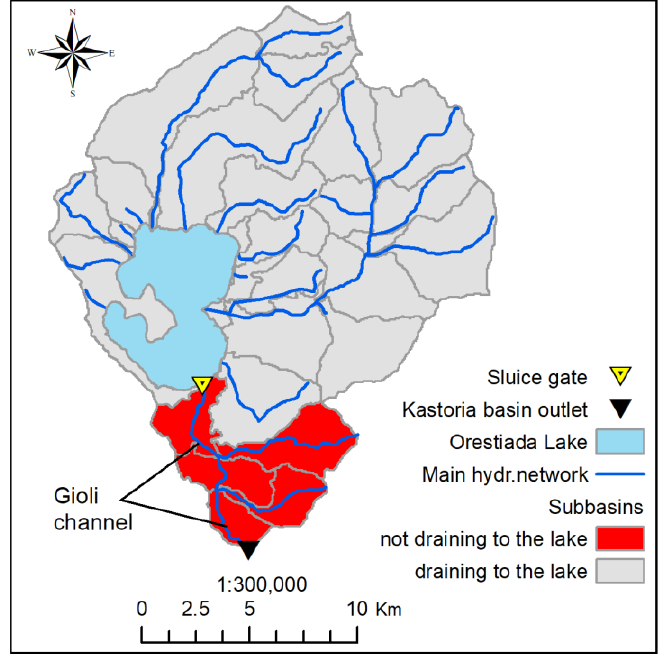
Figure 3. Delineation of Kastoria basin based on Arc-hydro module of Arc-Swat model.